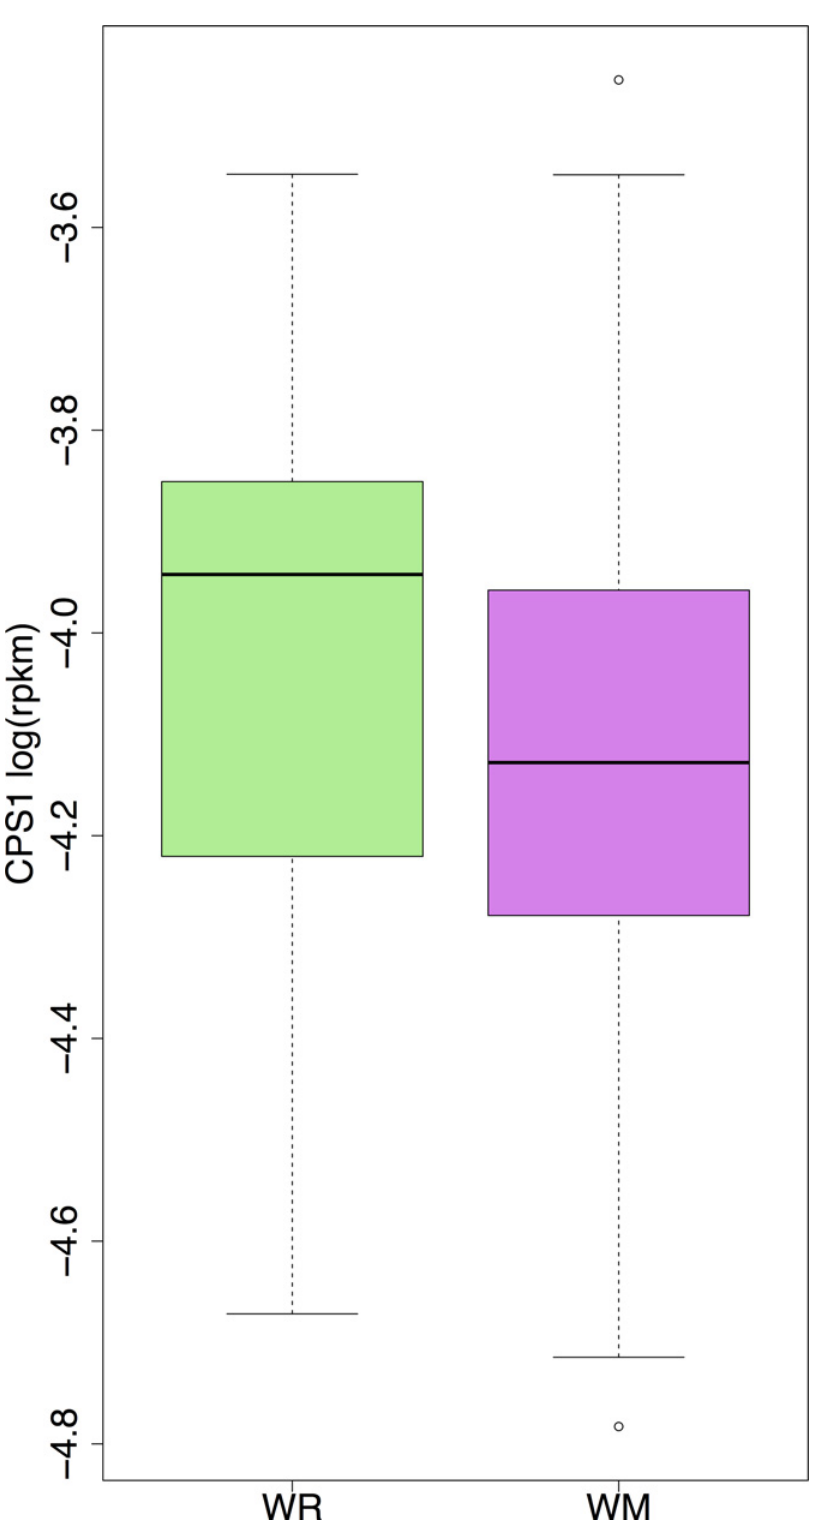
Fig 4. CPS1 gene expression and weight maintenance. Box plots for CPS1 gene expression at PWL, for weight maintainers (WMs) and weight maintenance resistors (WRs), defined as Δ BMI < 4% and Δ BMI > = 4% increase (p-value = 0.04, corrected for age and